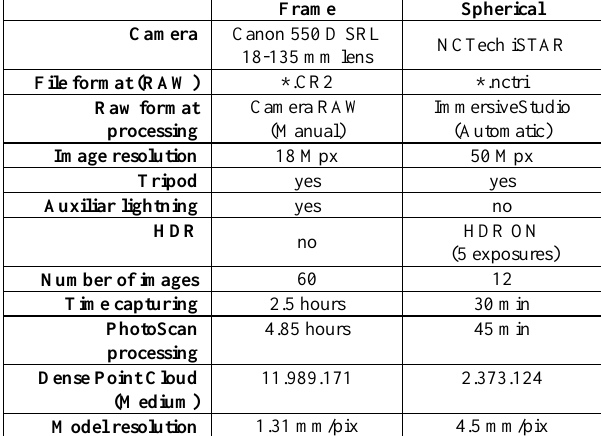
Table 1. Canon 550 D SRL frames compared to NCTech iSTAR HDR spherical